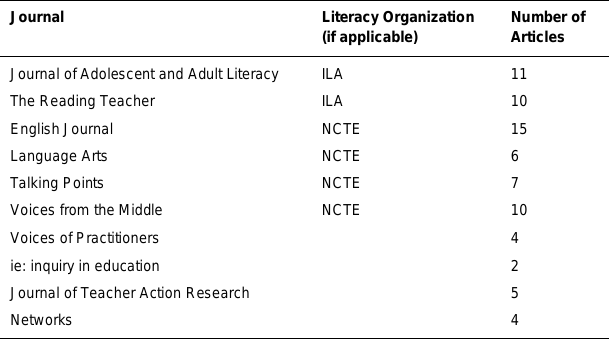
Table 1. Description of Sources (n